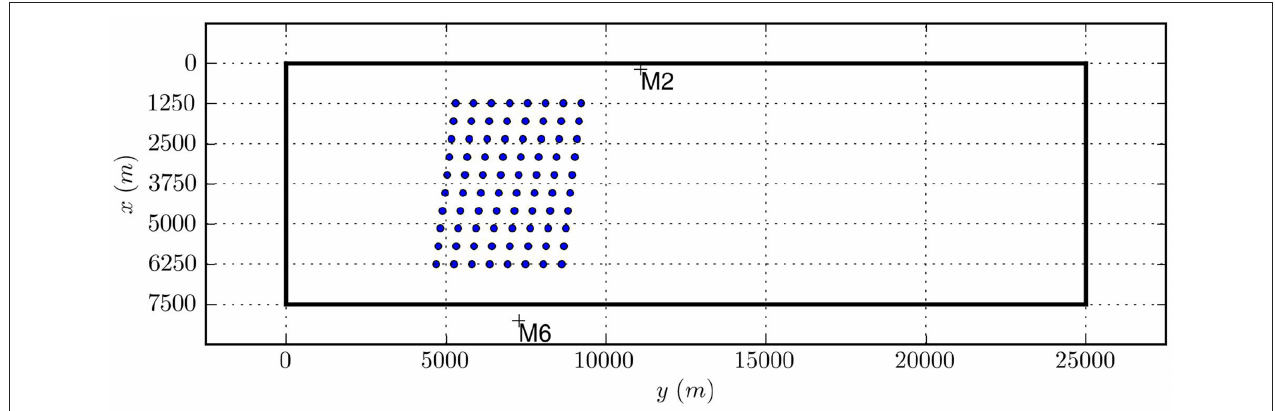
FIGURE 7 | Layout of the Horns Rev 1 offshore wind farm. The blue bullets ( • ) indicate the location of wind turbines. The black crosses (+) indicate the met masts position. The thick black box denotes the domain boundaries.